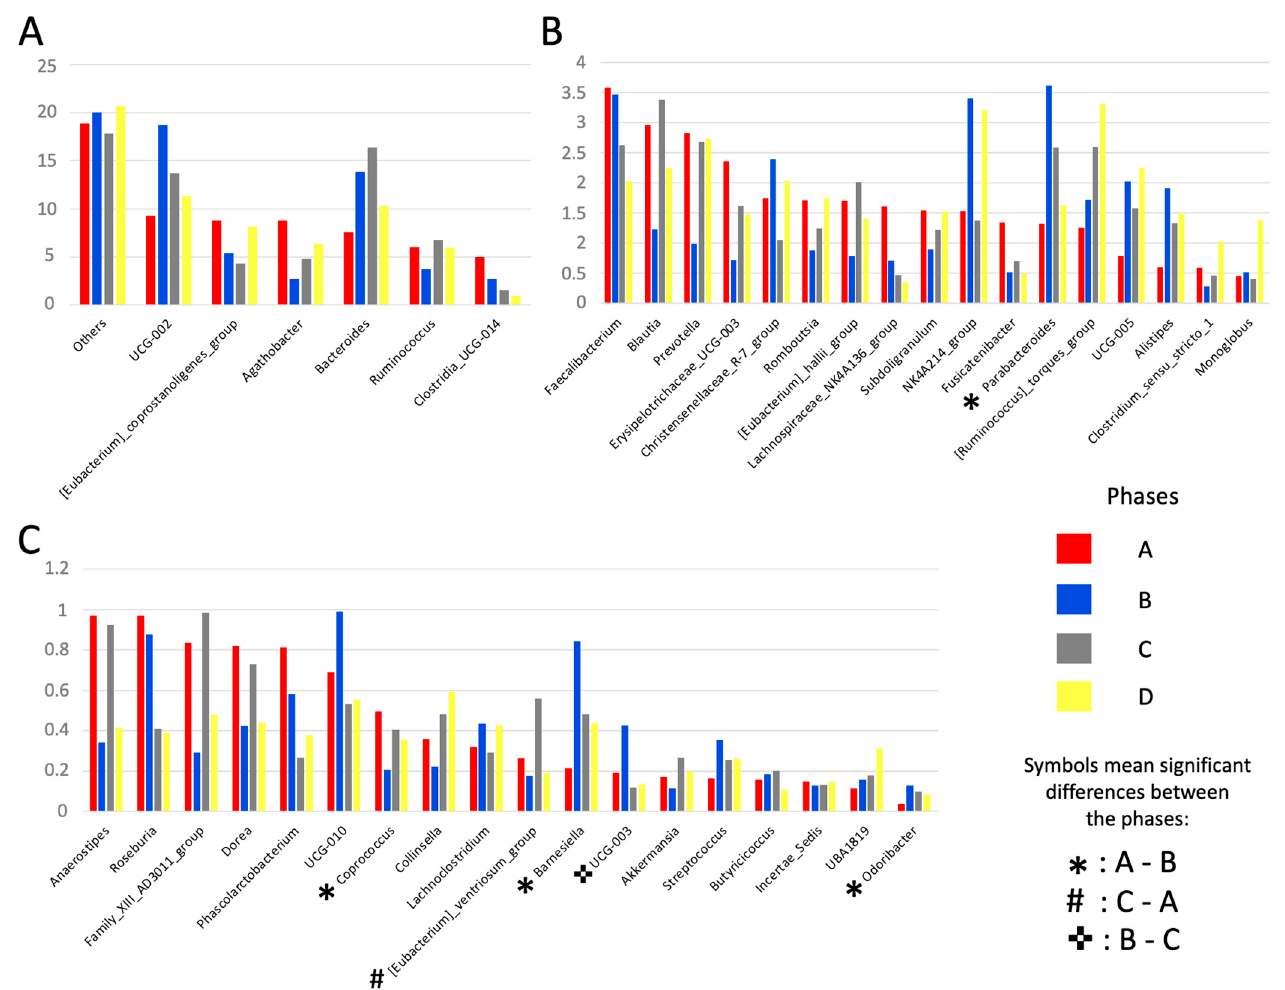
Figure 7. Bar plots of the relative abundance of each taxonomic group in percentage within each phase at genera level. ( A ) Taxa with a relative abundance ≥ 5% in at least one phase; ( B ) Taxa with a relative abundance ≥ 1% and <4% in at least one phase; ( C ) Taxa with a relative abundance < 1%. Others corresponds to the total sum of unassigned taxa. Symbols indicate significantly different taxa ( p -value ≤ 0.05) by non-parametric Kruskal–Wallis test.